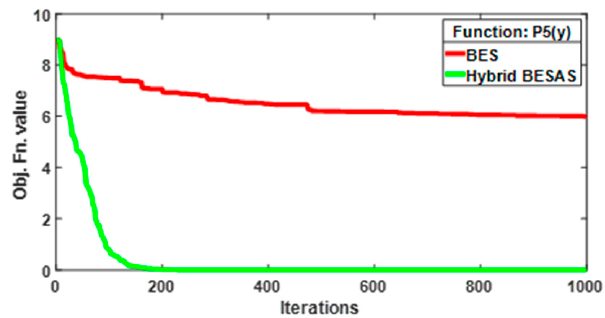
Figure 4. Convergence profile for function p 5 .